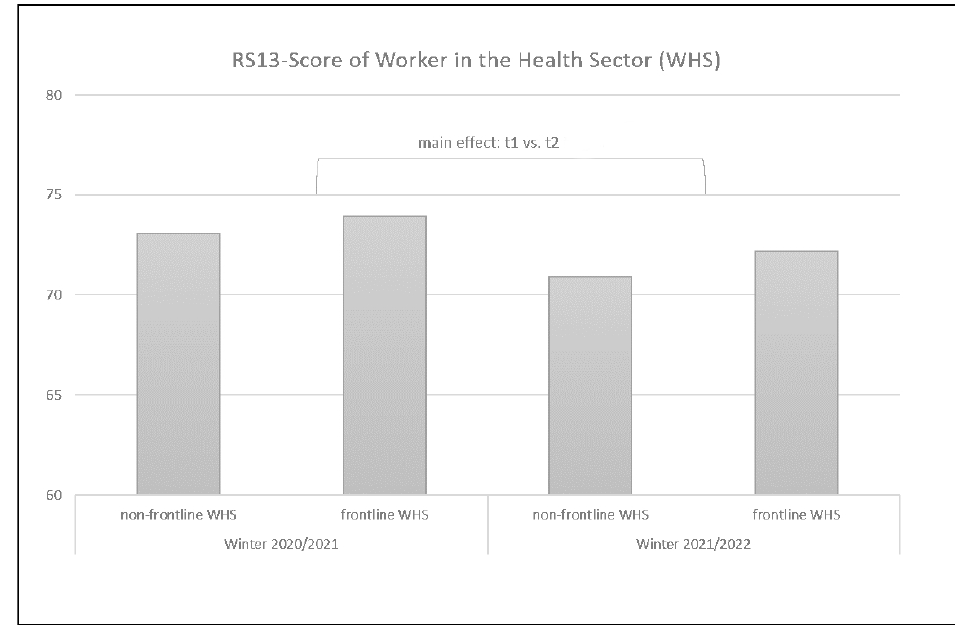
Figure 1. Repeated Measures ANCOVA (controlled for age and sex) in RS13-Scores for frontline vs. non-frontline WHS in 2020/2021 and 2021/2022. Table 4. Correlations between SHAPS and total resilience at both measurement